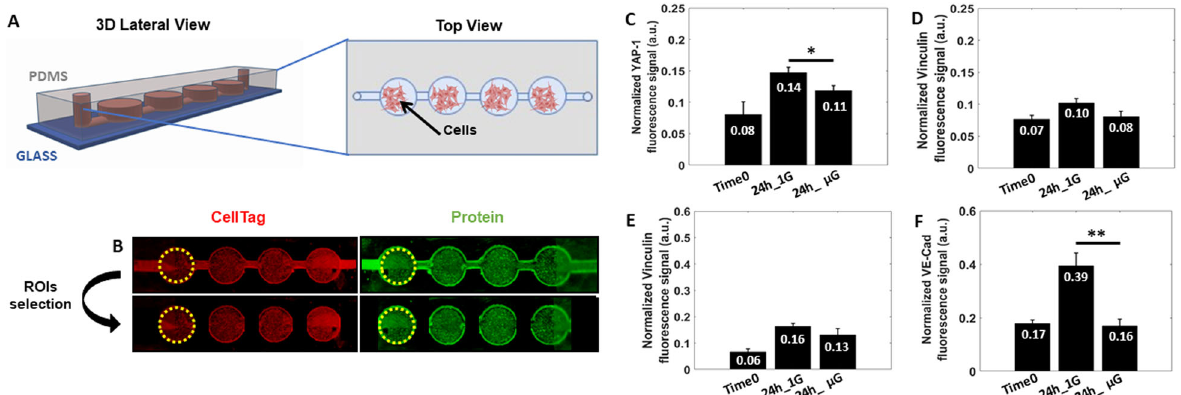
Fig. 5 Protein expression analysis. A Graphical rendering of the MOC showing the 3D lateral and Top view. B Example of IWB plate images showing Cell Tag 700 stain, in red, for cell number normalization and IRDye secondary antibodies, in green, for protein fl uorescence signal detection. A dashed yellow circle highlights the Region of Interest (ROI) selected for analysis. IWB assay for changes in Active Yap-1 ( C ) and Vinculin ( D ) proteins expression in response to 24 h of μ G condition, in Glioblastoma A-172. IWB assay for changes in Vinculin ( E ) and VE- Cadherin ( F ) proteins expression in response to 24 h of μ G condition, in HUVECs. Data are shown as the mean ± SEM ( n = 3). Asterisks are reported for cases with statistical signi fi cance: * YAP-1 24 h 1 G Vs 24 h μ G: p = 0.329, ** VE-Cadherin 24 h 1 G Vs 24 h μ G: p = 0.013. The statistical analysis of the data was performed using one-way analysis of variance (ANOVA) with Turkey ’ s test for multiple comparisons.